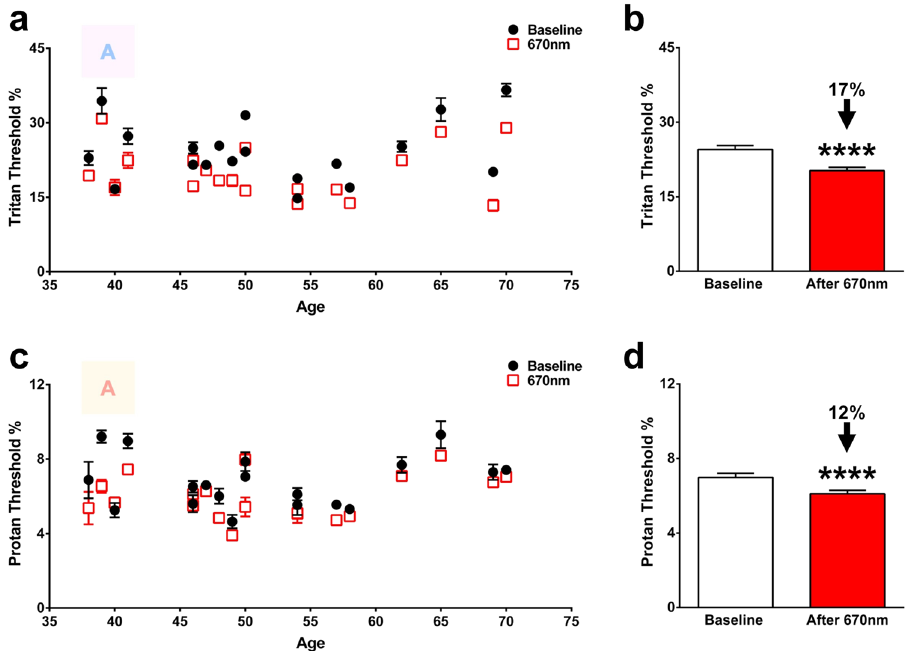
Figure 1. Colour contrast sensitivities (CCS) measured 3 h following a morning exposure (8-9AM) of 670 nm. CCS of tritan ( a ) and protan ( c ) axes measured in 20 healthy subjects and their response to 670 nm exposure. Black closed circles represent baseline measurements and red open boxes are those in the same individuals measured 3 h following a single 3 min 670 nm exposure delivered in the morning. The colour letter A in both graphs is an example of the target to be identified as it appeared on the screen. ( b ) Thresholds for tritan function in individuals 38–70 years. Most subjects displayed a significant decrease to their tritan thresholds following light exposure. Overall, there was a 17% reduction to thresholds across the population. ( d ) Thresholds for protan function in individuals 38–70 years, with half the population displaying a significant decrease to their protan thresholds after 670 nm exposure. Total protan thresholds were reduced by 12% across all subjects. Wilcoxon matched-pairs signed rank test was used for statistical analysis. Data are presented as means ± SEM. ****p < 0.0001. Age related differences were not apparent in the baseline measurements as was apparent in Shinhmar et al. (2020). This was because the age range covered here was shorter than in the previous study with a tendency for clustering in the middle age